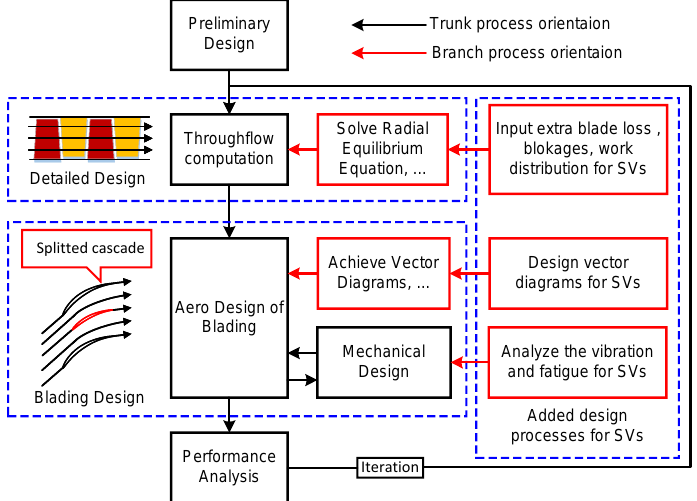
Figure 1. A typical flowchart of the design of a splittered axial flow compressor. Appl. Sci. 2017 , 7 , 283